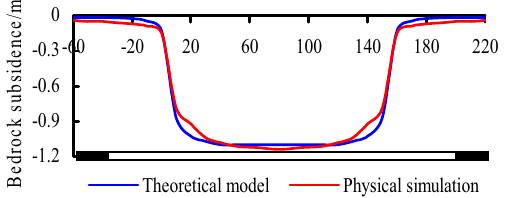
Figure 15. Bedrock subsidence curves.